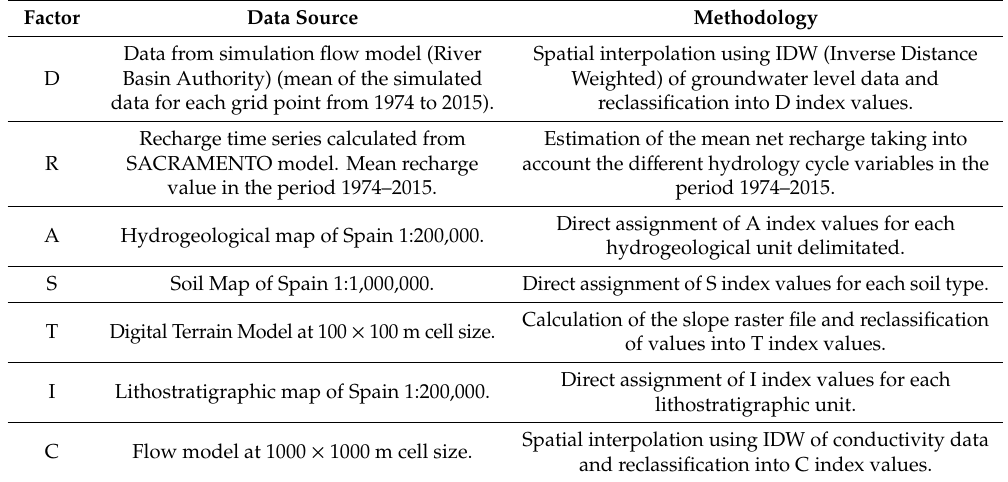
Table A4. Data source and methodology to calculate DRASTIC